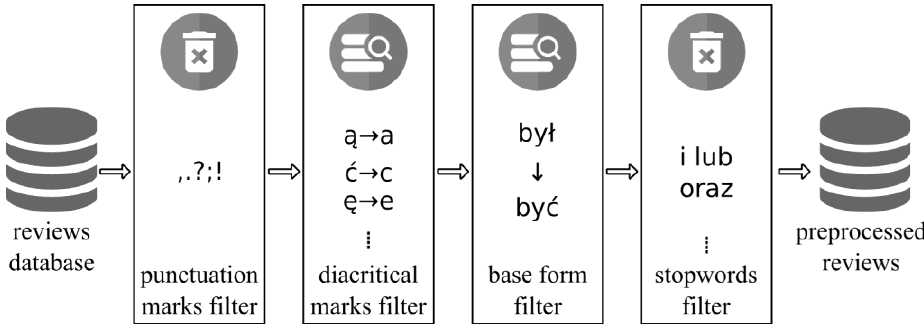
Fig. 4. The data pre-processing